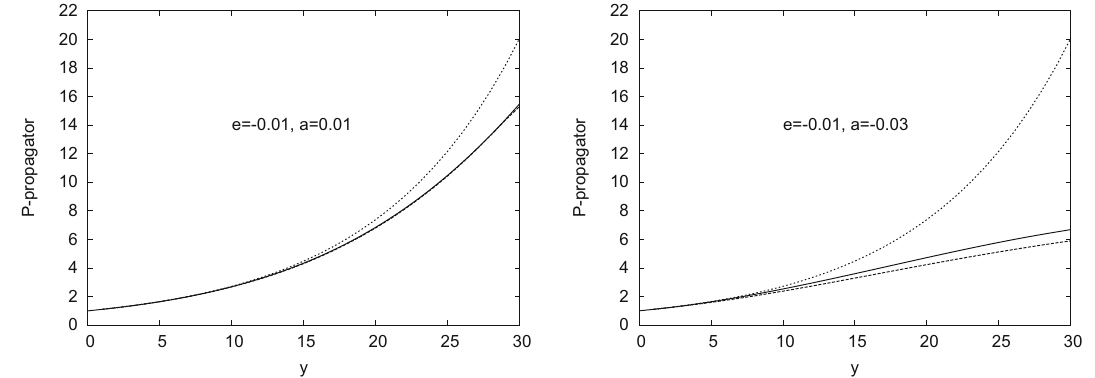
Fig. 5 The pomeron propagators as functions of rapidity for μ = 0 . 1, λ = 0 . 01 (left panel) and 0 . 03 (right panel). Our results with both the pomeron and odderon loops are shown in the middle curve, those with only the pomeron loops in the bottom curve and without loops in the upper curve